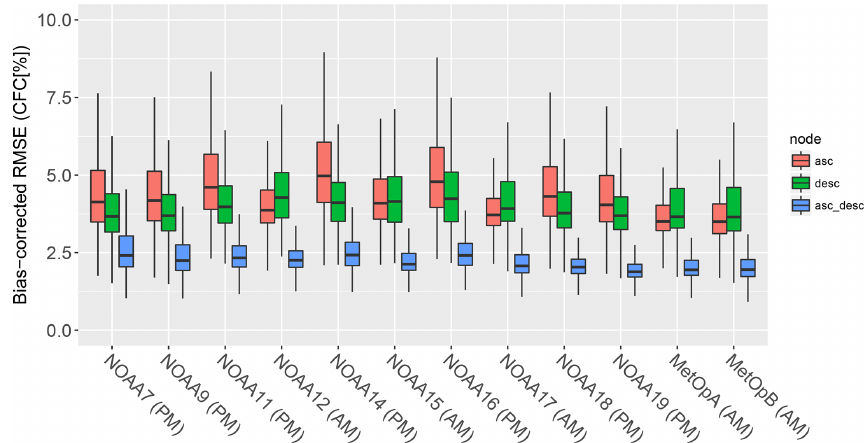
Figure 7. Distribution of the CFC bias-corrected root mean square error caused by the discrete sampling of the CFC diurnal cycle presented for each NOAA satellite and each node (asc – ascending, desc – descending, and asc_desc – ascending and descending combined). The lower and upper hinges correspond to the 25th and 75th percentiles, while whiskers extend from the hinge to the largest and lowest values within 1.5 times the interquartile range.